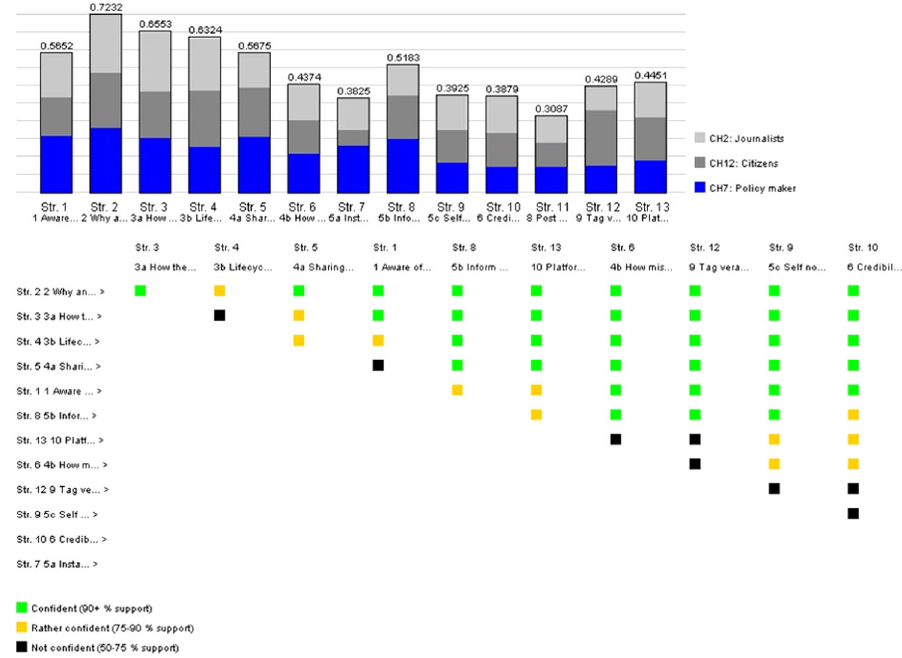
Fig. 1 Results for all groups of stakeholders. Preferences.